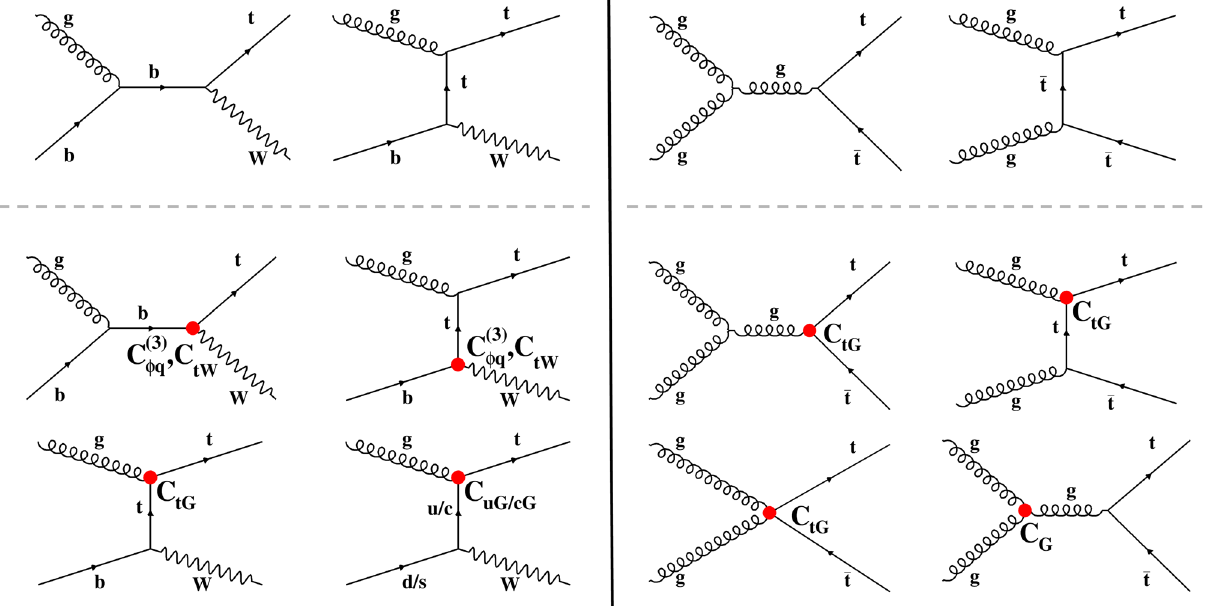
Fig. 1 Representative Feynman diagrams for the tW (left panel) and t ¯ t (right panel) production at leading order. The upper row presents the SM diagrams, the middle and lower rows present diagrams corresponding to the O